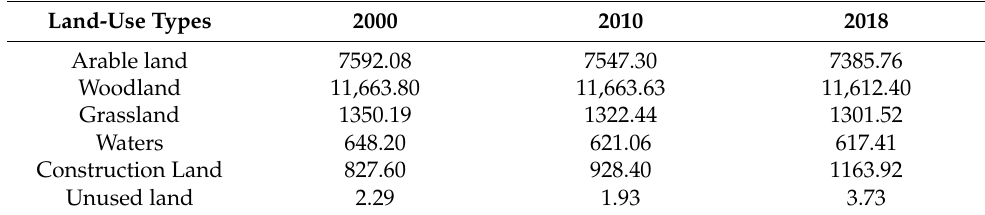
Table 3. Areas of LU types in Nanning from 2000 to 2018 (km 2